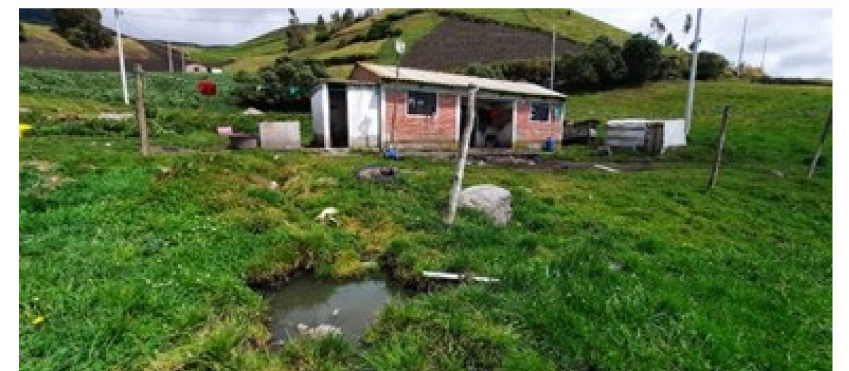
Figure 2. House with a leaky septic tank underground.